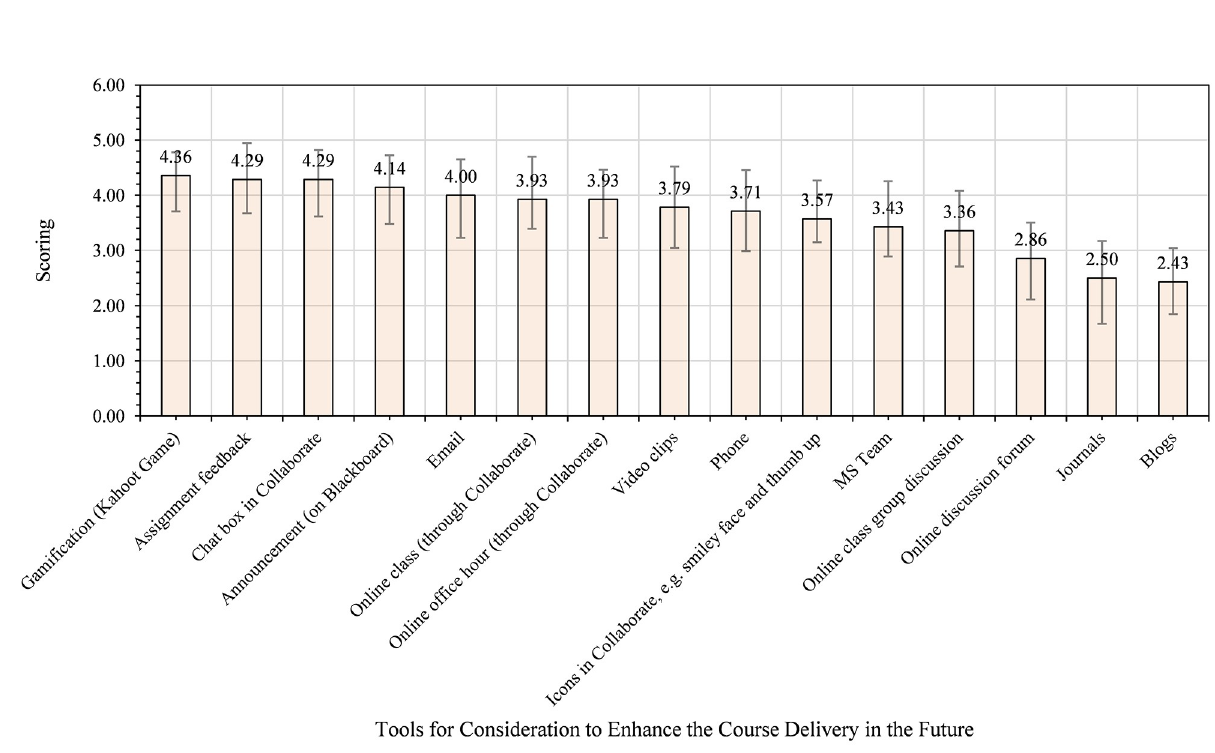
Fig 10. Arts, humanities and social sciences, and business students’ views on tools for enhancing course delivery in the future.